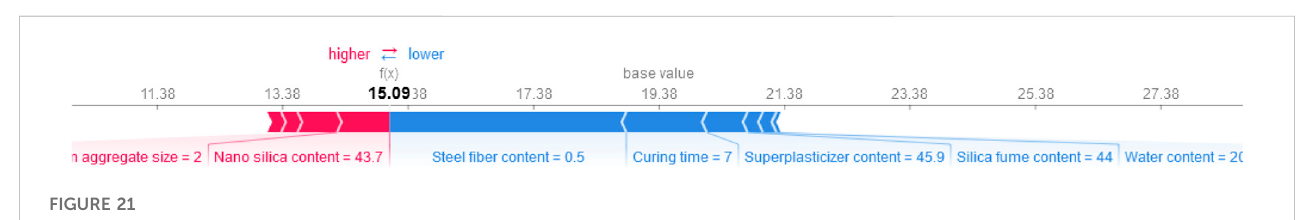
FIGURE 21 SHAP plot for UHPC